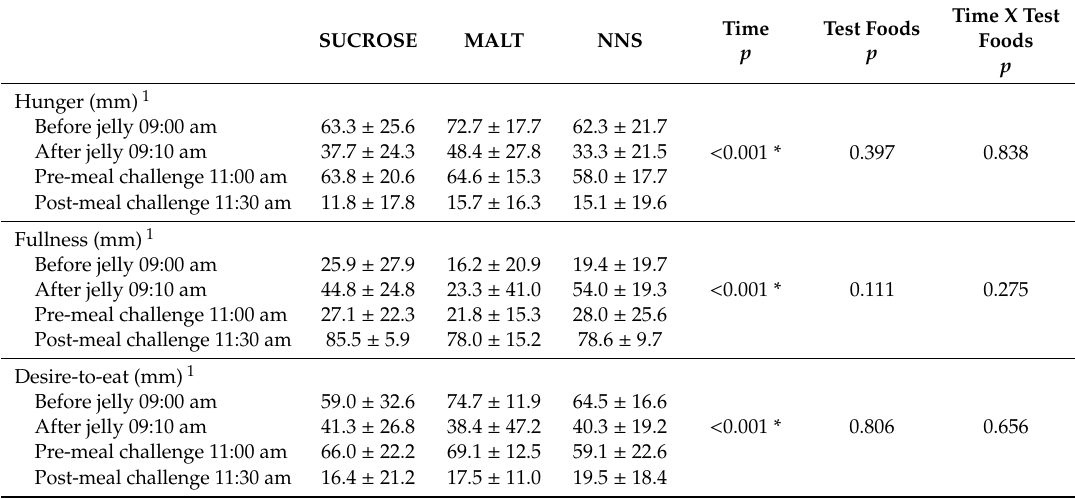
Table 2. Hunger, fullness and desire-to-eat ratings before and after test food ingestion, as well as before and after meal challenge ( n =